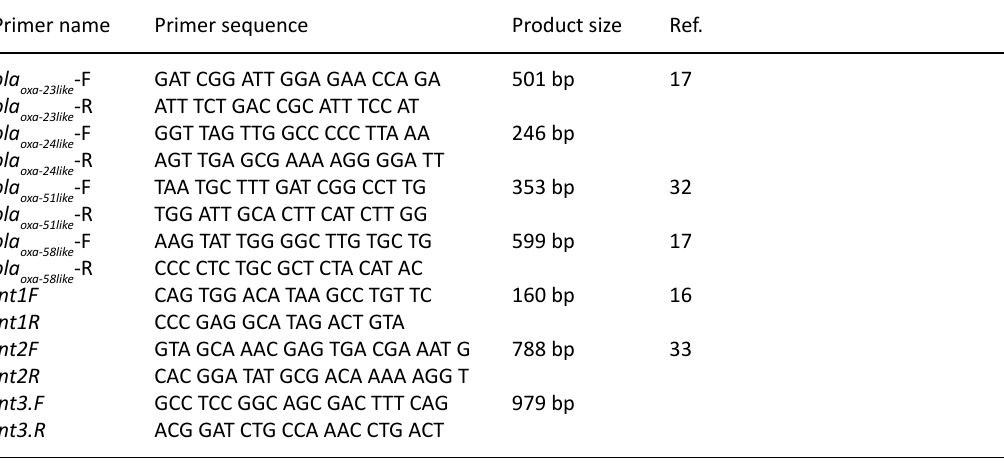
Table 1. PCR primers for the detection of genes encoding OXA carbapenemase and class-I, class-II and class-III